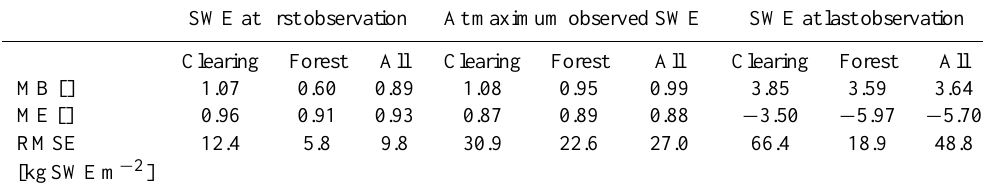
Table 4. Model bias index (MB), model efficiency index (ME) and root mean square error (RMSE) for simulations of SWE at the first SWE observation, maximum SWE observation, and last SWE observation at clearing sites, forest sites, and all sites. SWE at first observation At maximum observed SWE